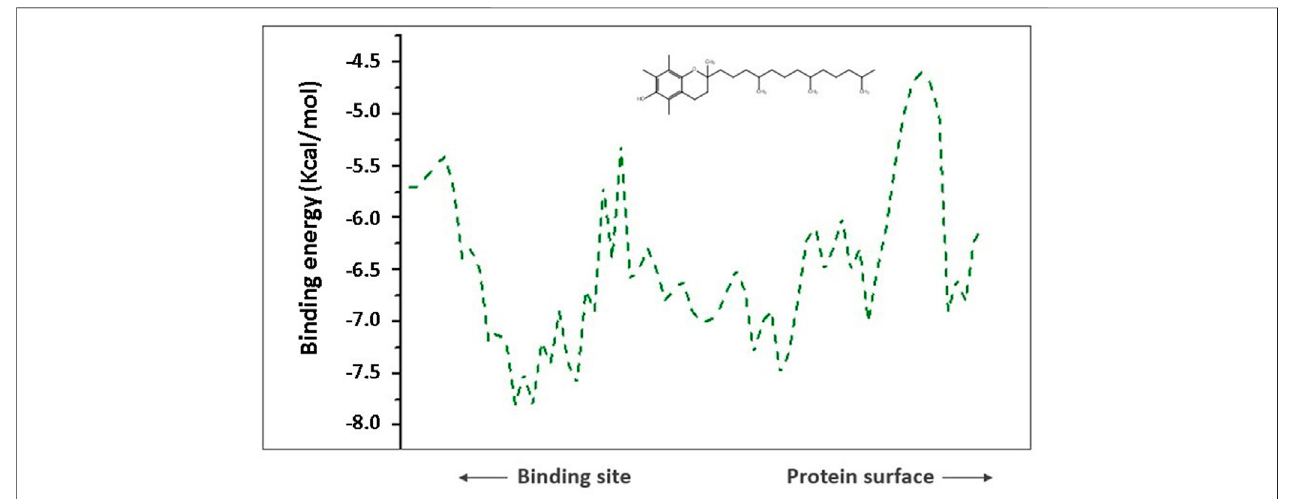
FIGURE 5 | Representation of binding energies, trajectory and tunnel radius for α -tocopherol in tunnel 3.